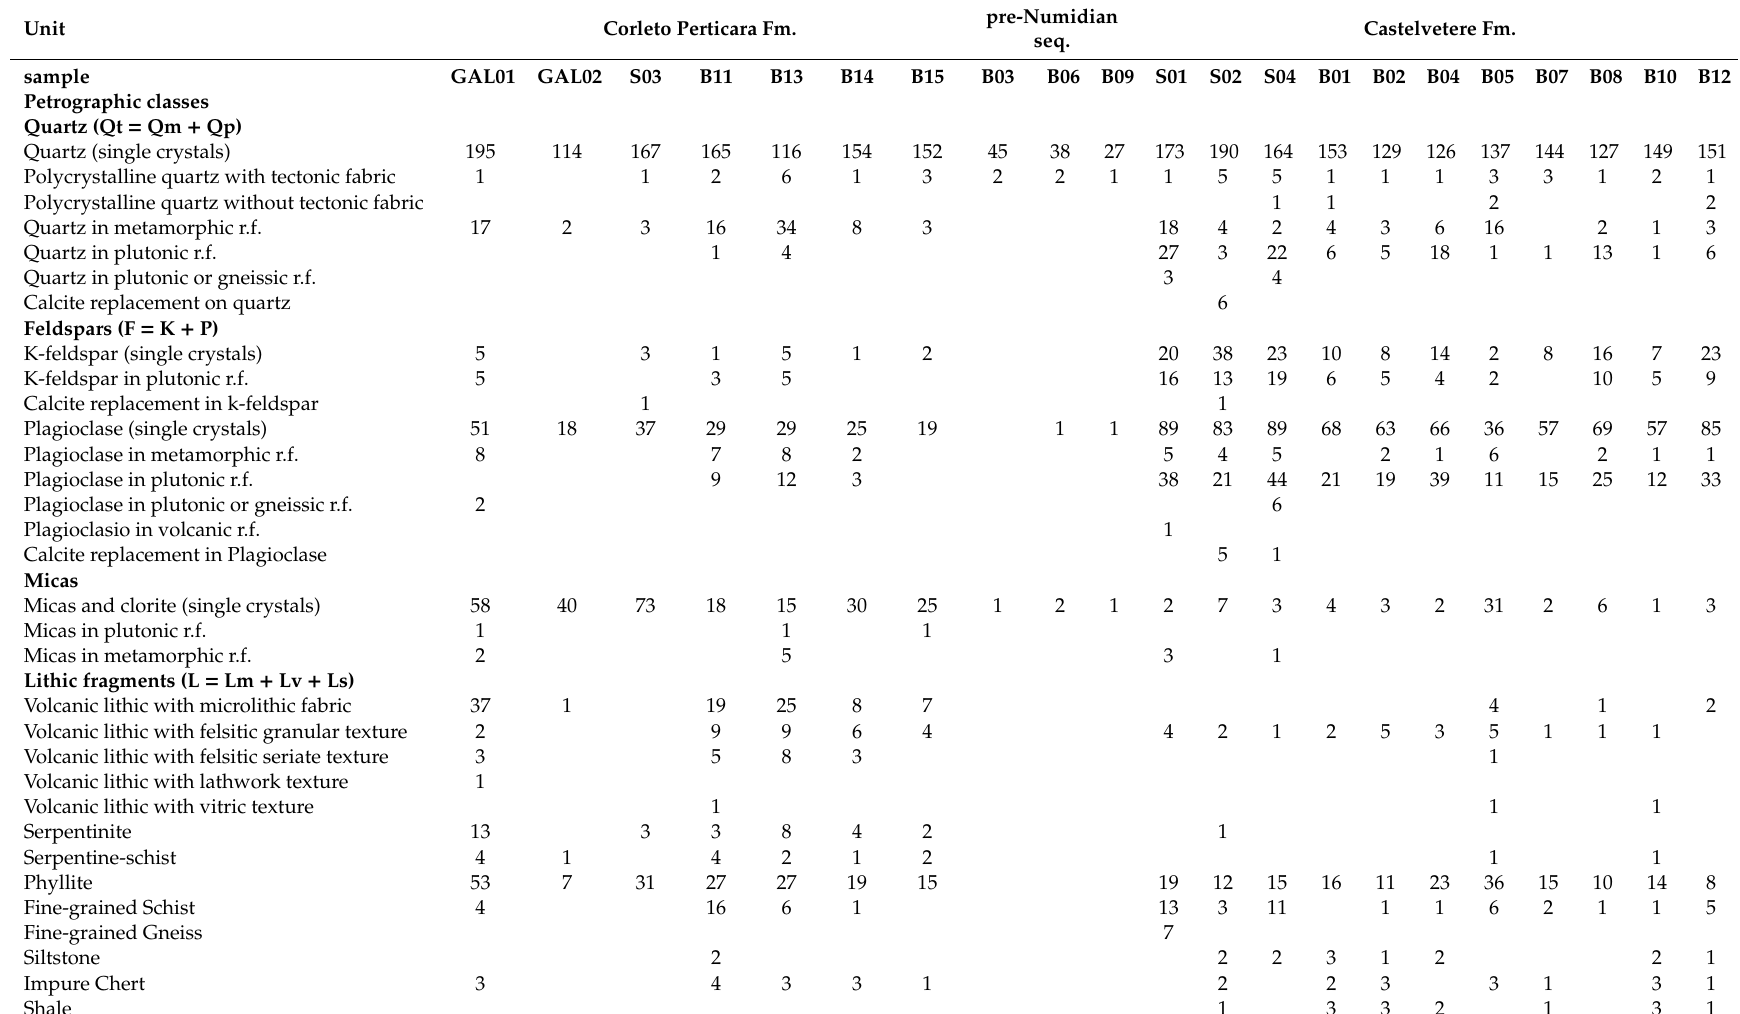
Table 3. Point-count raw results of the analyzed sandstone